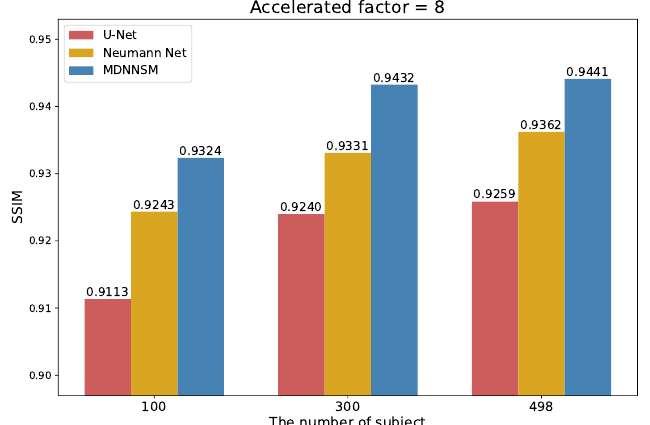
Figure 8. SSIM score according to the amount of training data at an acceleration factor of